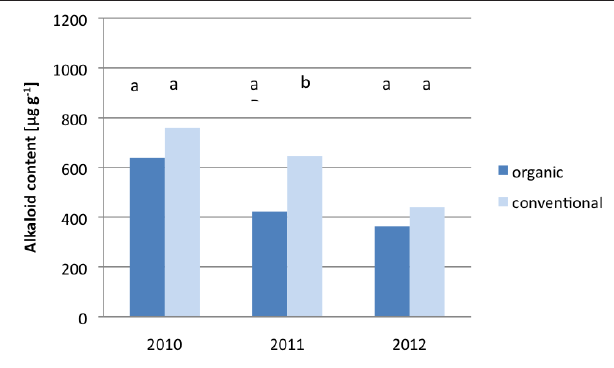
Tab. 1: Results of the ANOVA for alkaloid content.